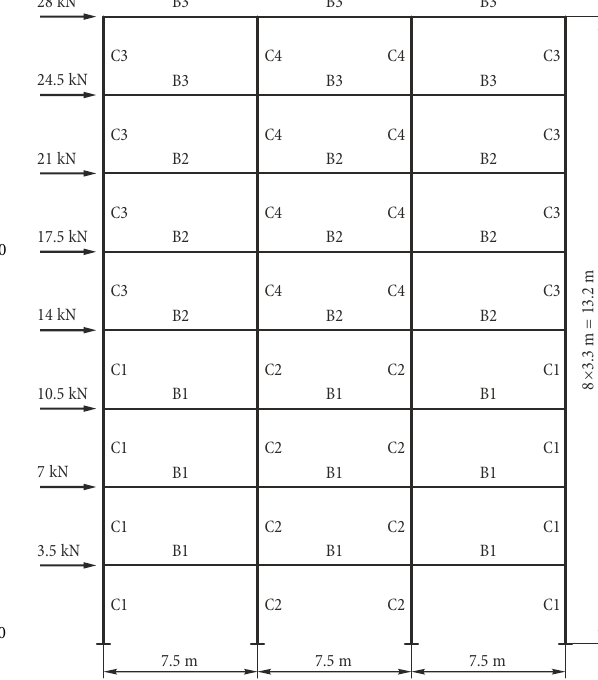
Fig. 8. Maximum values of the congestion distance in the first model (C.D.: congestion distance) Fig. 9. Topology of the second